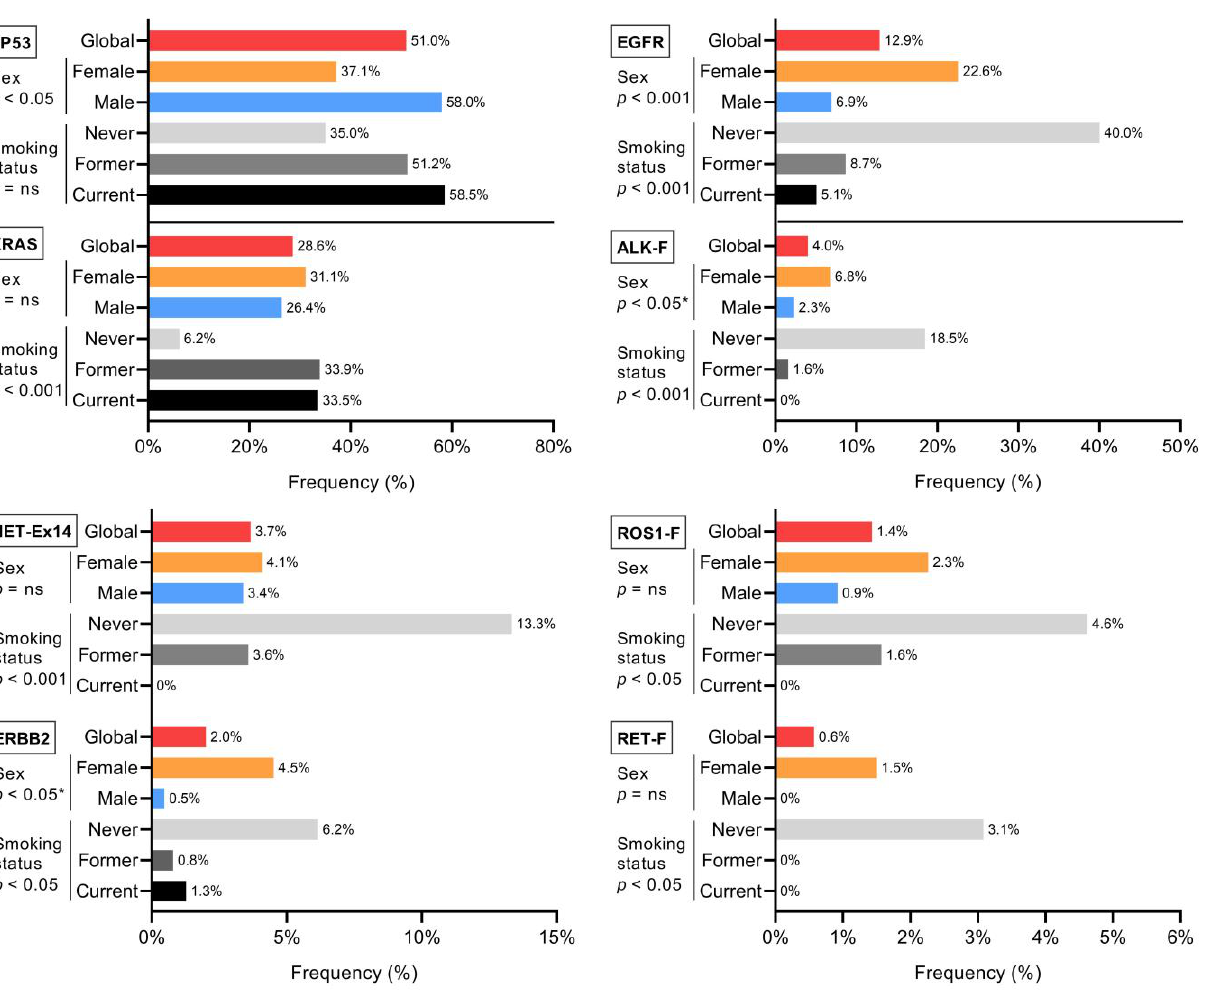
Figure 2. Association of sex and smoking status with specific molecular alterations. Frequency of gene alterations in the global cohort and in the evaluated subgroups is depicted. ns: not statistically significant. * Comparison using Fisher’s exact test.